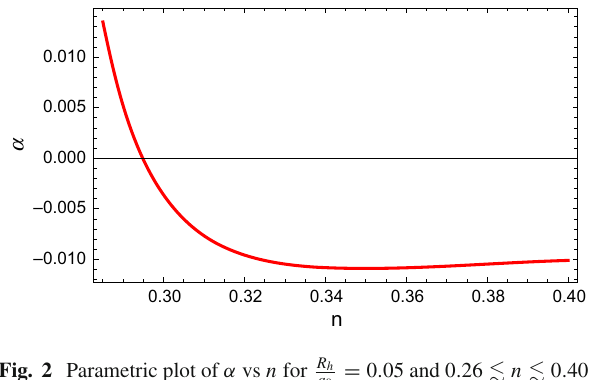
= 0 . 05 and 0 . 26 (cid:2) n (cid:2) 0 . a 0